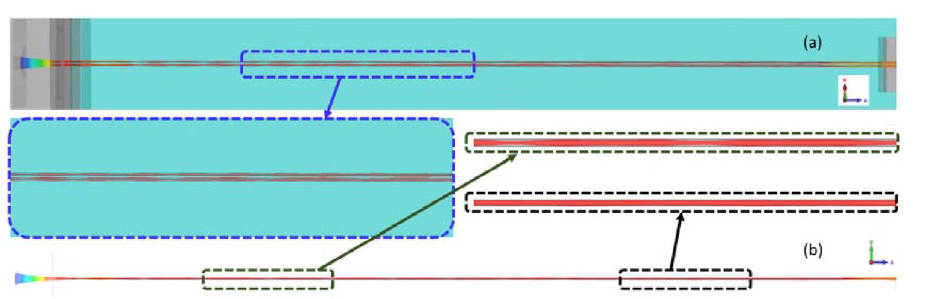
Figure 15. Trajectory of the double pencil beams under the uniform magnetic system with Br = 1.4 T. ( a ) x-o-z plane. ( b ) y-o-z